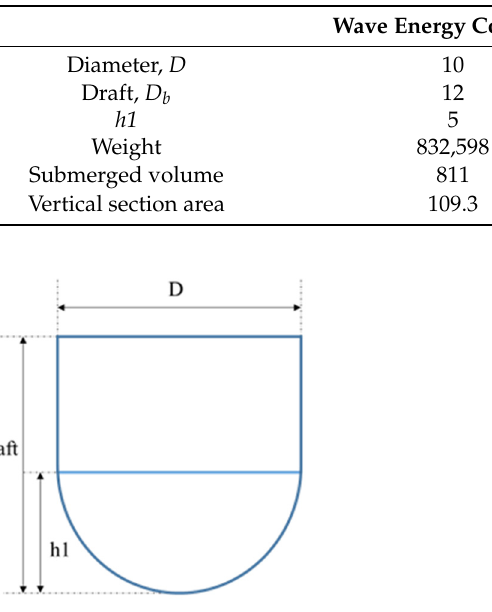
Figure 1. Sketch of the floating structure.